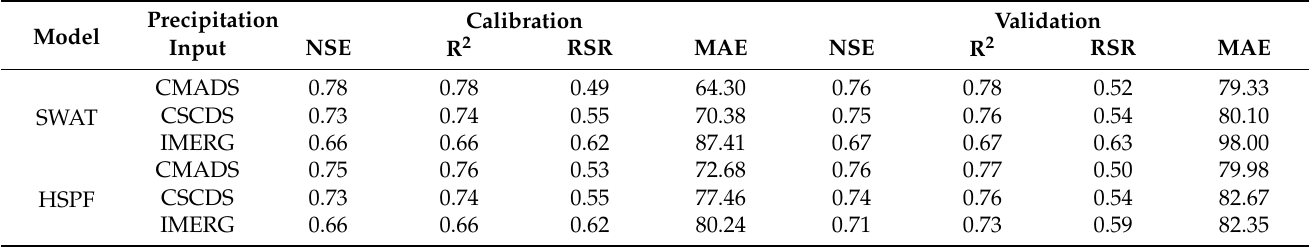
Table 4. Comparison of the simulation results of two models driven by three types of precipitation